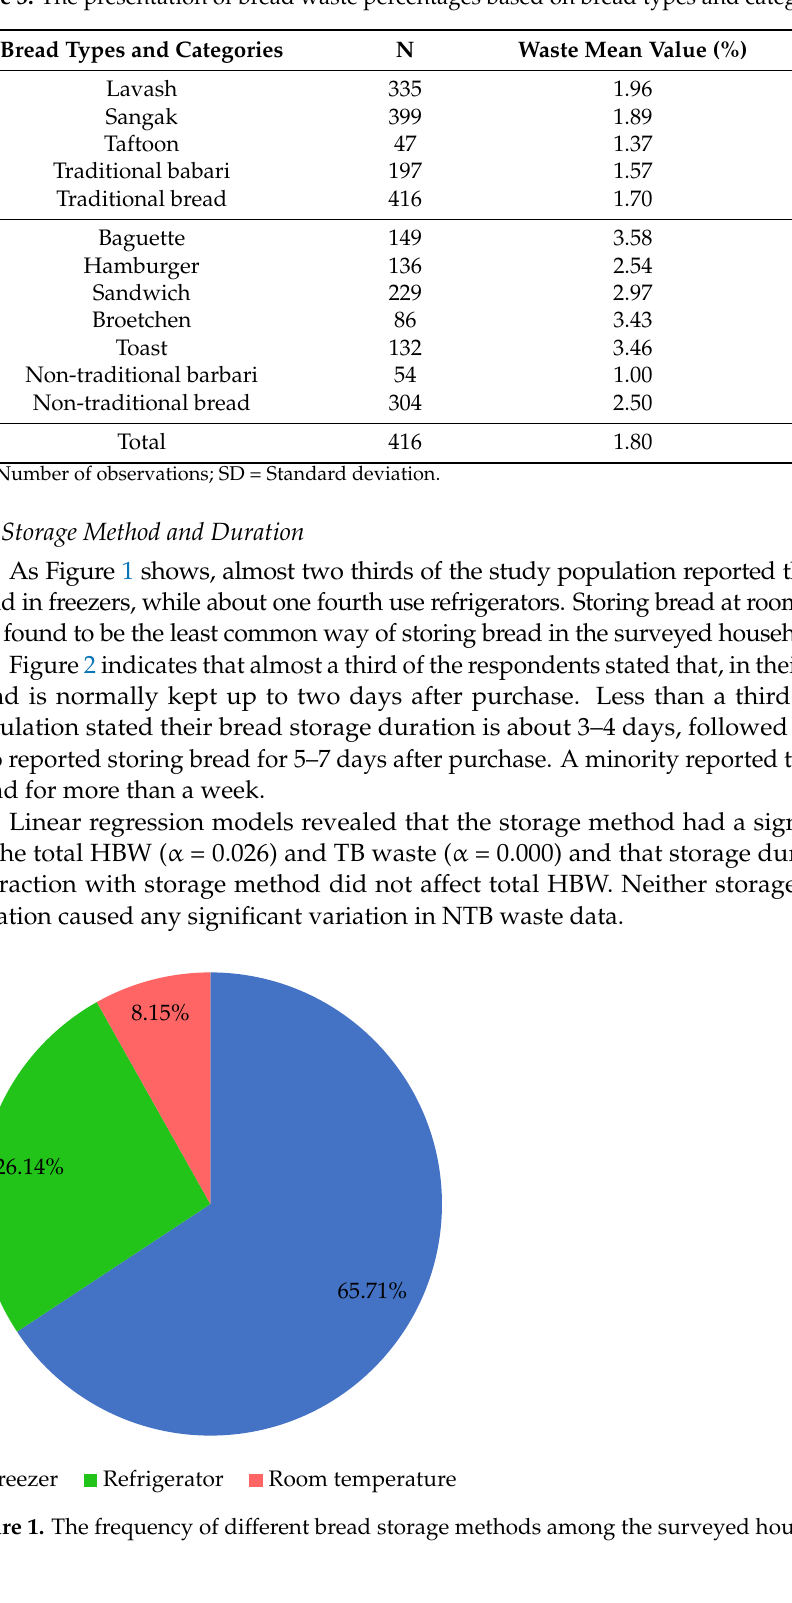
Table 3. The presentation of bread waste percentages based on bread types and categories.